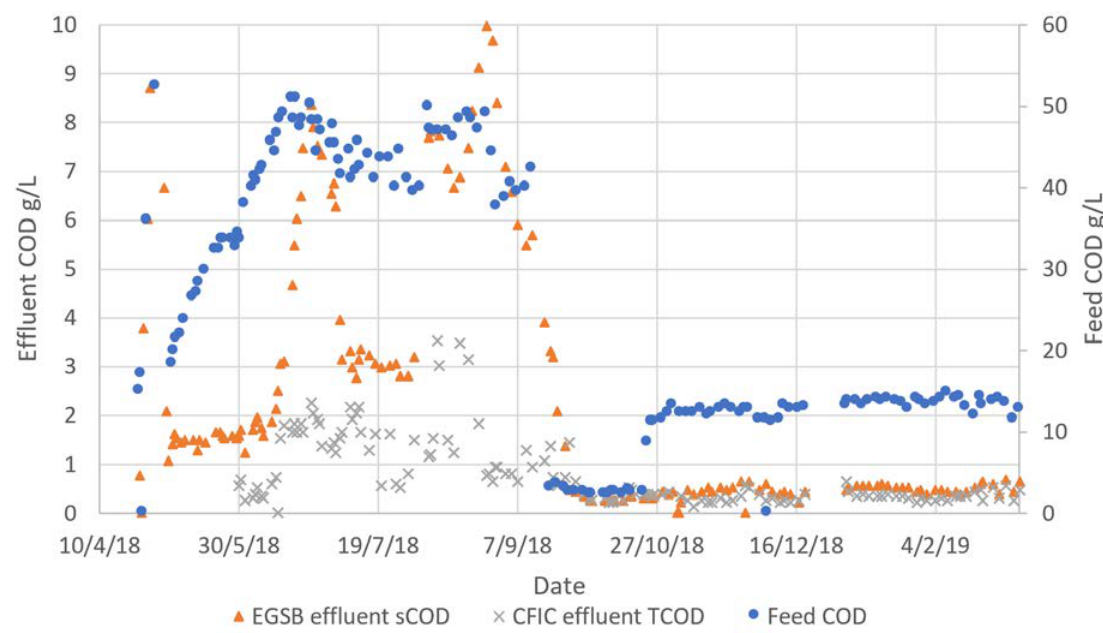
Figure 7. Feed, EGSB effluent sCOD and CFIC effluent TCOD concentrations.